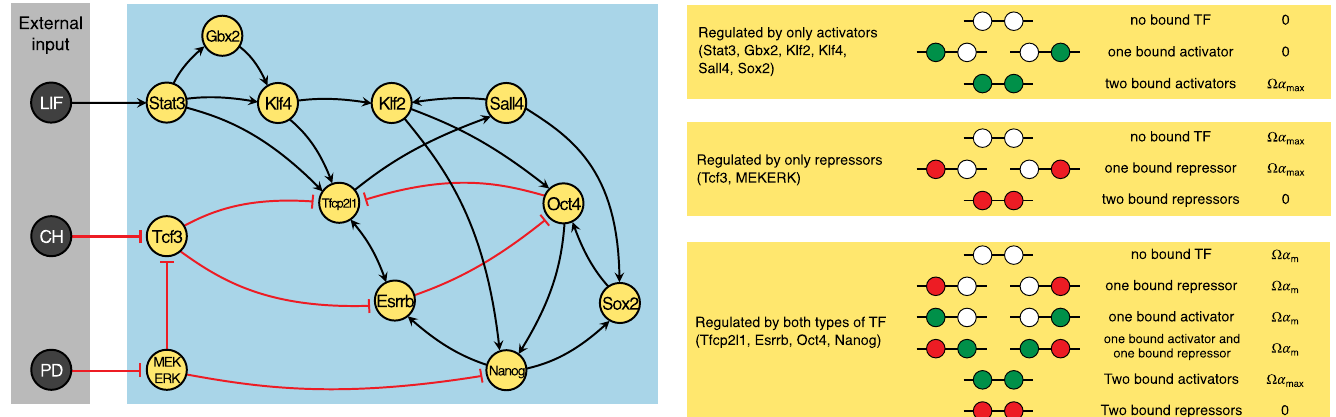
Fig 1. Network topology and molecular logic. The left panel shows a schematic diagram of the network topology, reproduced from Dunn et al. [16]. Each node corresponds to a given gene and their placement from left to right is chosen to indicate a trend of downstreamness from three external inputs. In our mechanistic model, each gene produces a unique transcription factor at a rate which depending on the binding state of its promoter site. These transcription factors then go on to bind and activate (black arrow) or repress (red bar) other genes. The three nodes on left correspond to extra-cellular signals, which are either absent or present. The right panel shows our assumed molecular logic of transcriptional regulation when there are N = 2 promoter sites per gene. Each circle is a binding site: it can be either empty (white), bound by an activator (green), or bound by a repressor (red). The right panel lists possible combinations of the promoter sites. Depending on the configuration of the promoter site, transcription factors are produced with rates 0, O α m , and O α max , modeling the effects of cooperative binding.